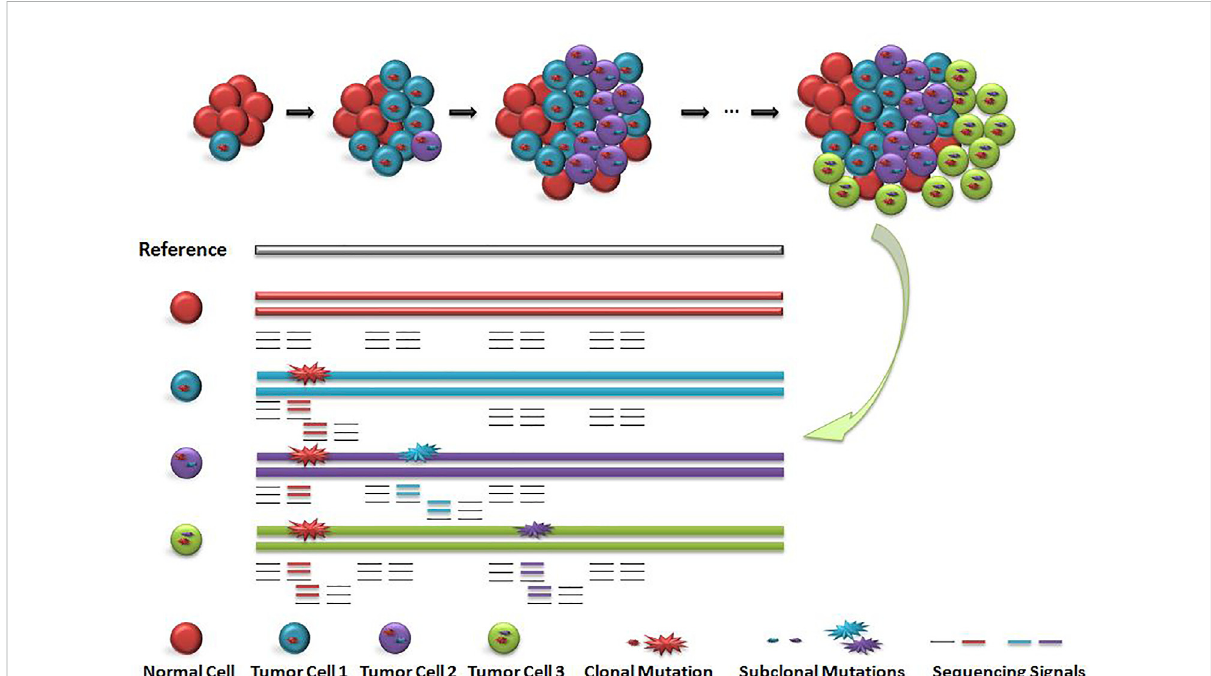
FIGURE 1 Schematic diagram of subclonal variation and detection signals. When the main clone and sub clone were included, the cell distribution and sequencingsignal werediluted.Red circleindicatesthemainclonevariation,bluecircle andpurplecircleindicatethesequencingsignalofsubclone variation. The value of sequencing signal of sub-clone variation is closely related to the number and proportion of corresponding cells, but the distribution of the number of cells including main clone and subclone is unknown, so the value of sequencing signal is dif fi cult to